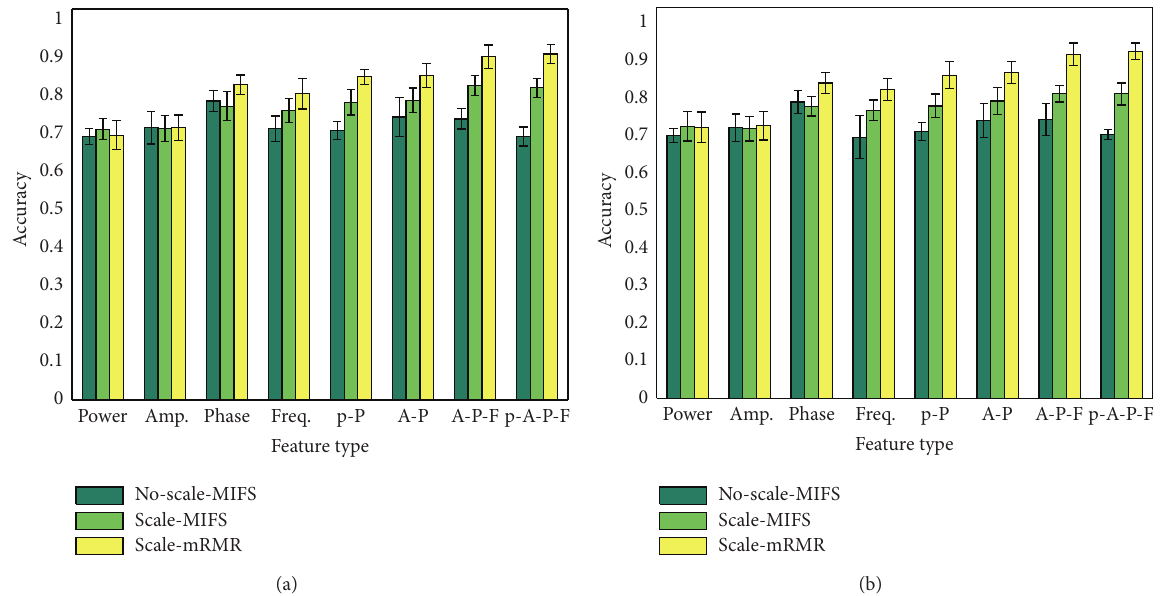
Figure 6: The comparison of three different feature extraction methods: the first one is no-scaled feature chosen by MIFS feature selection criterion; the second one is scaled feature chosen by MIFS feature selection criterion; the last one is scale feature chosen by mRMR feature selection criterion. (a) The comparison using ELMs. (b) The comparison using